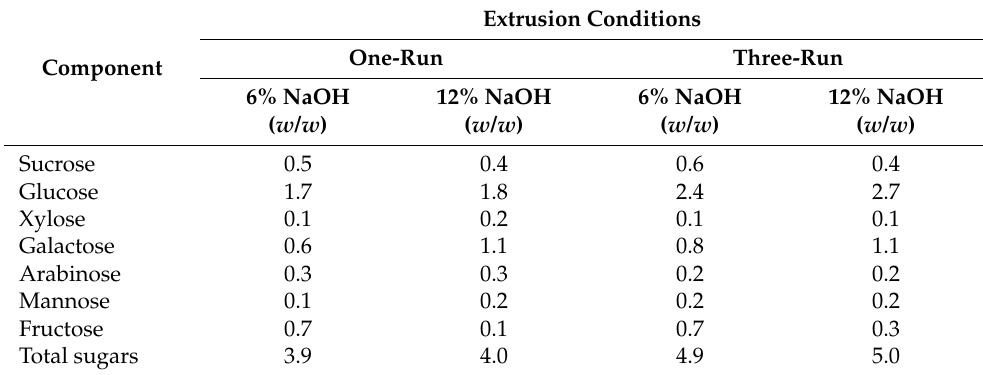
Table 4. Sugar composition for the soluble fractions collected during each extrusion pretreatment. Data expressed as g/100 g of